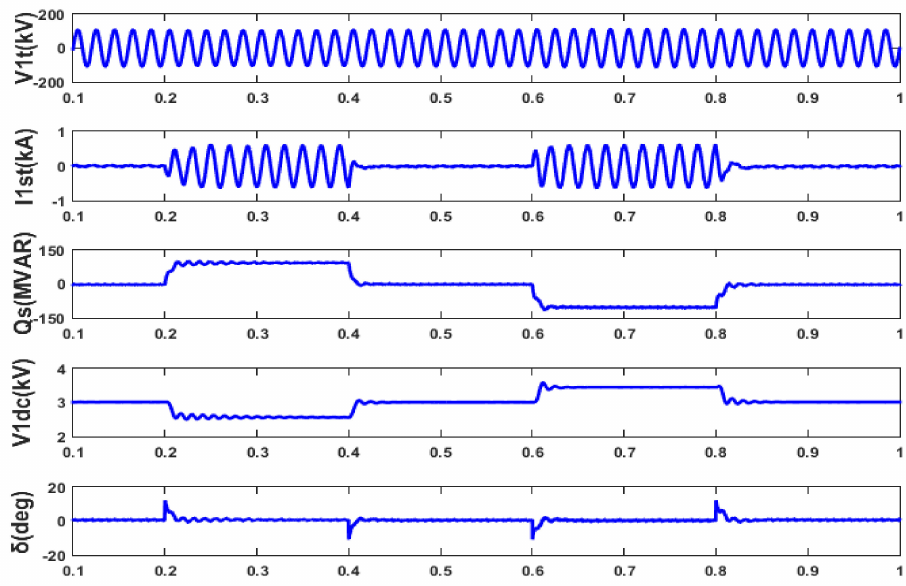
Figure 3. Continuous load performance results of seven level VSC based STATCOM with reference reactive power